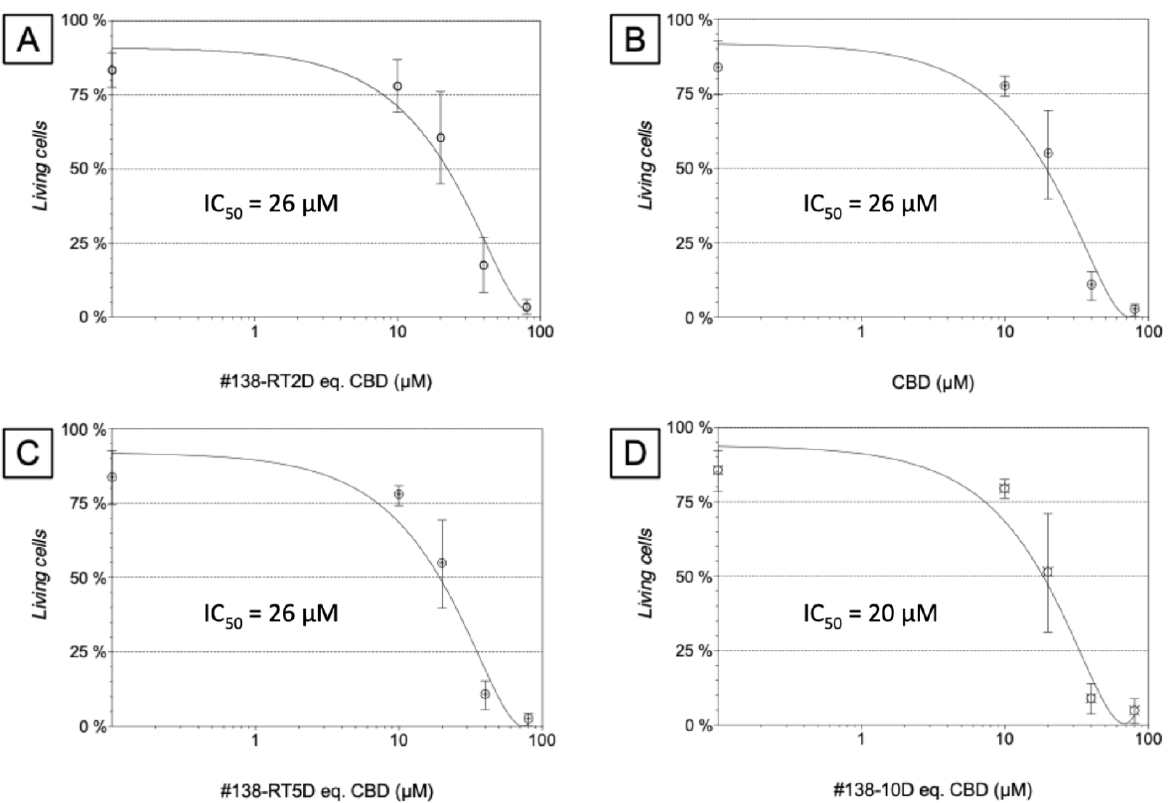
Figure 2. Effects of the different ethanolic extract on cellular apoptosis induction on the human pancreatic cancer cell line. The cells were treated with indicated concentrations for 48 h, and then induction of apoptosis was analyzed by flow cytometry using annexin-V and propidium iodide IP. Dose response estimates to find out the concentration that caused inhibition of 50% cell viability (IC 50 ). Values are mean ± S.E.M of 7 independent experiments of the three #138 extracts with n = 3 for CBD alone. Computed EC 50 values are given inside the graph for each treatment: ( A ) extract #138 RT-2D ( B ) pure CBD ( C ) extract #138 RT-5D ( D ) extract